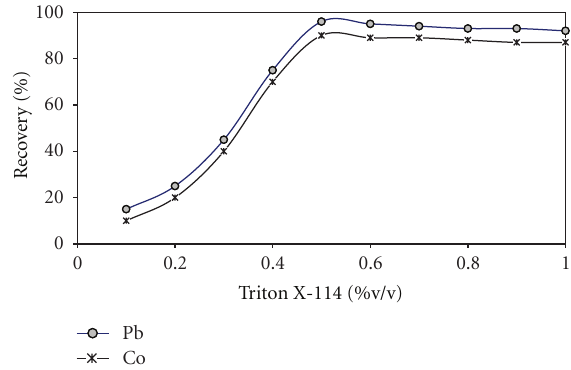
Figure 2: E ff ect of Triton X-114 on the percentage of recovery: 20 µ g L − 1 of Pb and Co, 5 . 0 × 10 − 3 molL − 1 oxine, pH 7.0, temperature 50 ◦ C, and centrifugation time 10 min (3500rpm).